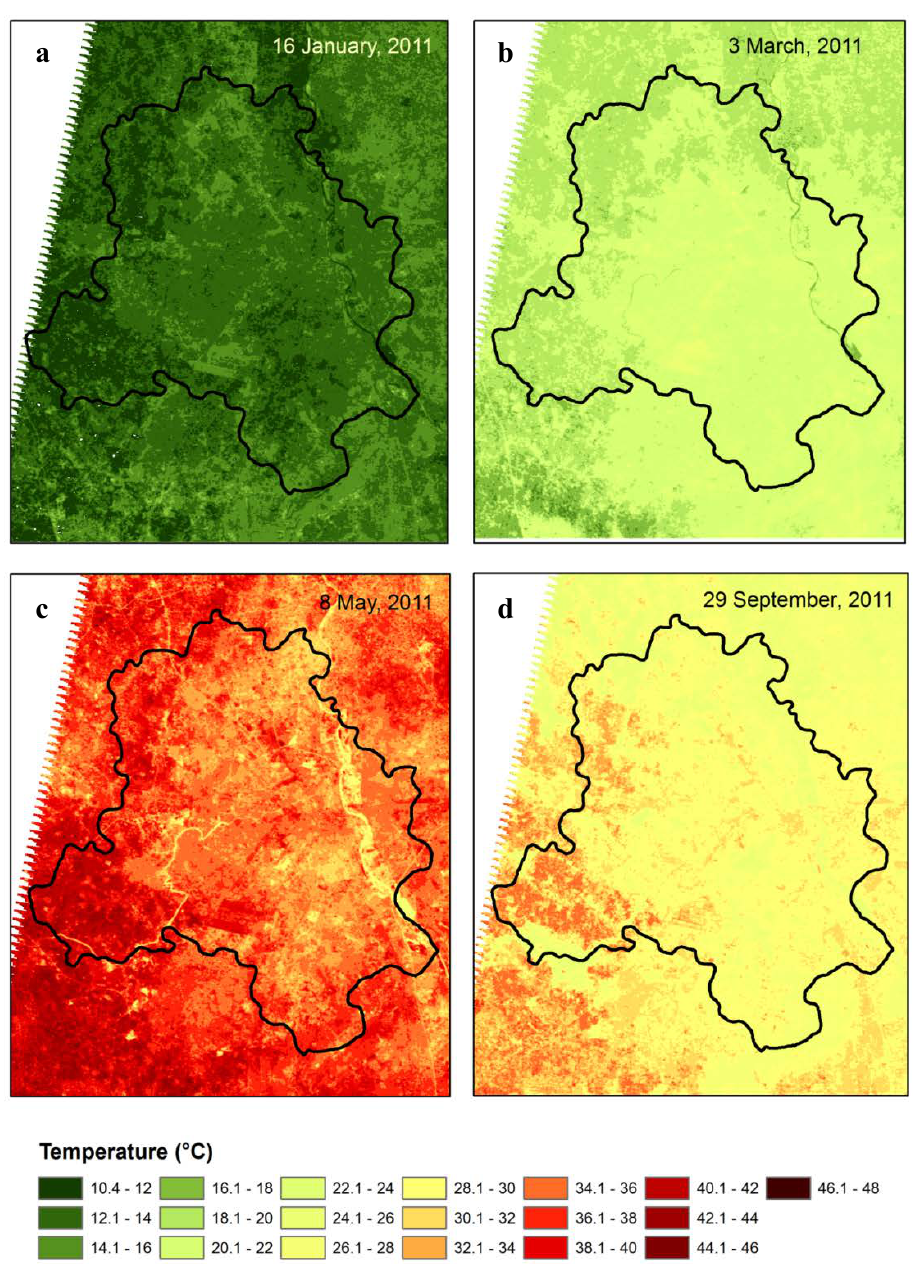
Figure 4. Inter-seasonal variations of spatial patterns of surface temperature in